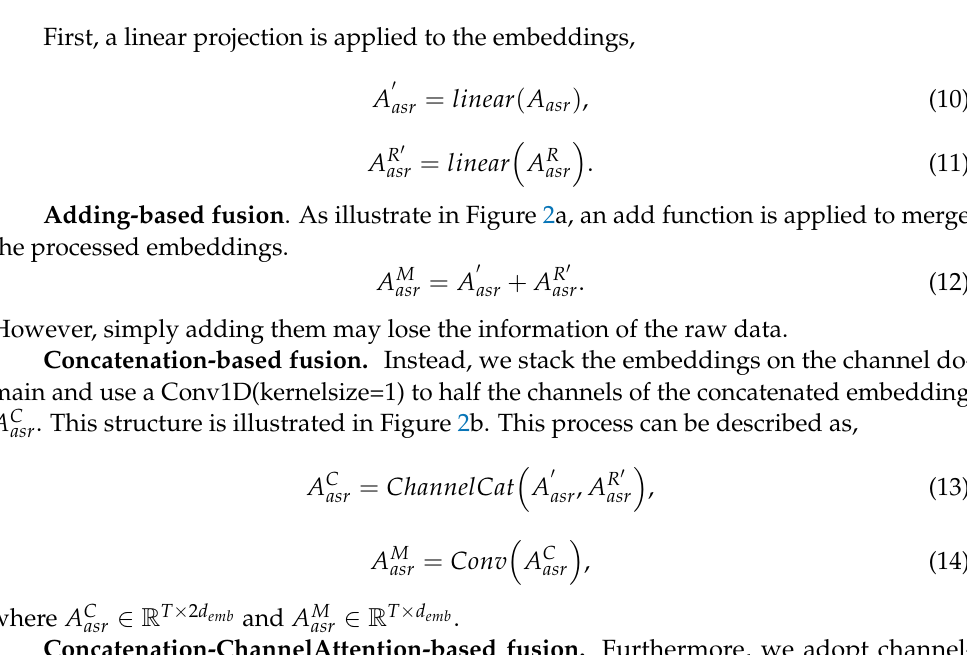
Figure 2. Fusion block with different structures. ( a ) Adding-based fusion. ( b ) Concatenation-based fusion. ( c ) Concatenation–ChannelAttention-based fusion. In ( b , c ), a Conv1D layer with kernelsize=1 is adopted to cast the concatenated channels 2 ∗ d emb back to d emb